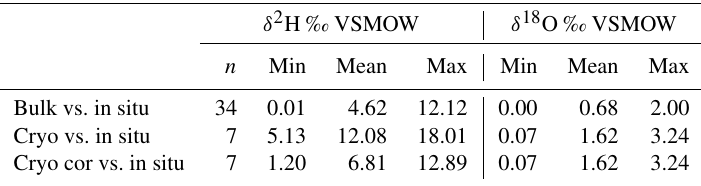
Figure 8. Box plots showing the isotopic composition as well as lc-excess of daily precipitation sampling, weekly sampled groundwater, lake and stream water, in situ sampled soil, and xylem water. The lc-excess is an indicator of evaporational effects and describes the offset of the sample from the LMWL (see Sect. 3.4). Table 2. Variance of Euclidean distance between in situ and direct equilibrium (“bulk”) soil stable water isotopes and between cryogenic extracted twig and in situ xylem stable water isotopes. Euclidean distances were calculated between the δ 2 H (or δ 18 O) bulk (or cryogenic extracted) and δ 2 H (or δ 18 O) in situ point and the 1 : 1 line. In situ data were taken from the day of sampling bulk (or twig) samples. The results from “cryo cor” refer to corrected δ 2 H values where 8.1‰ was added (see Chen et al.,